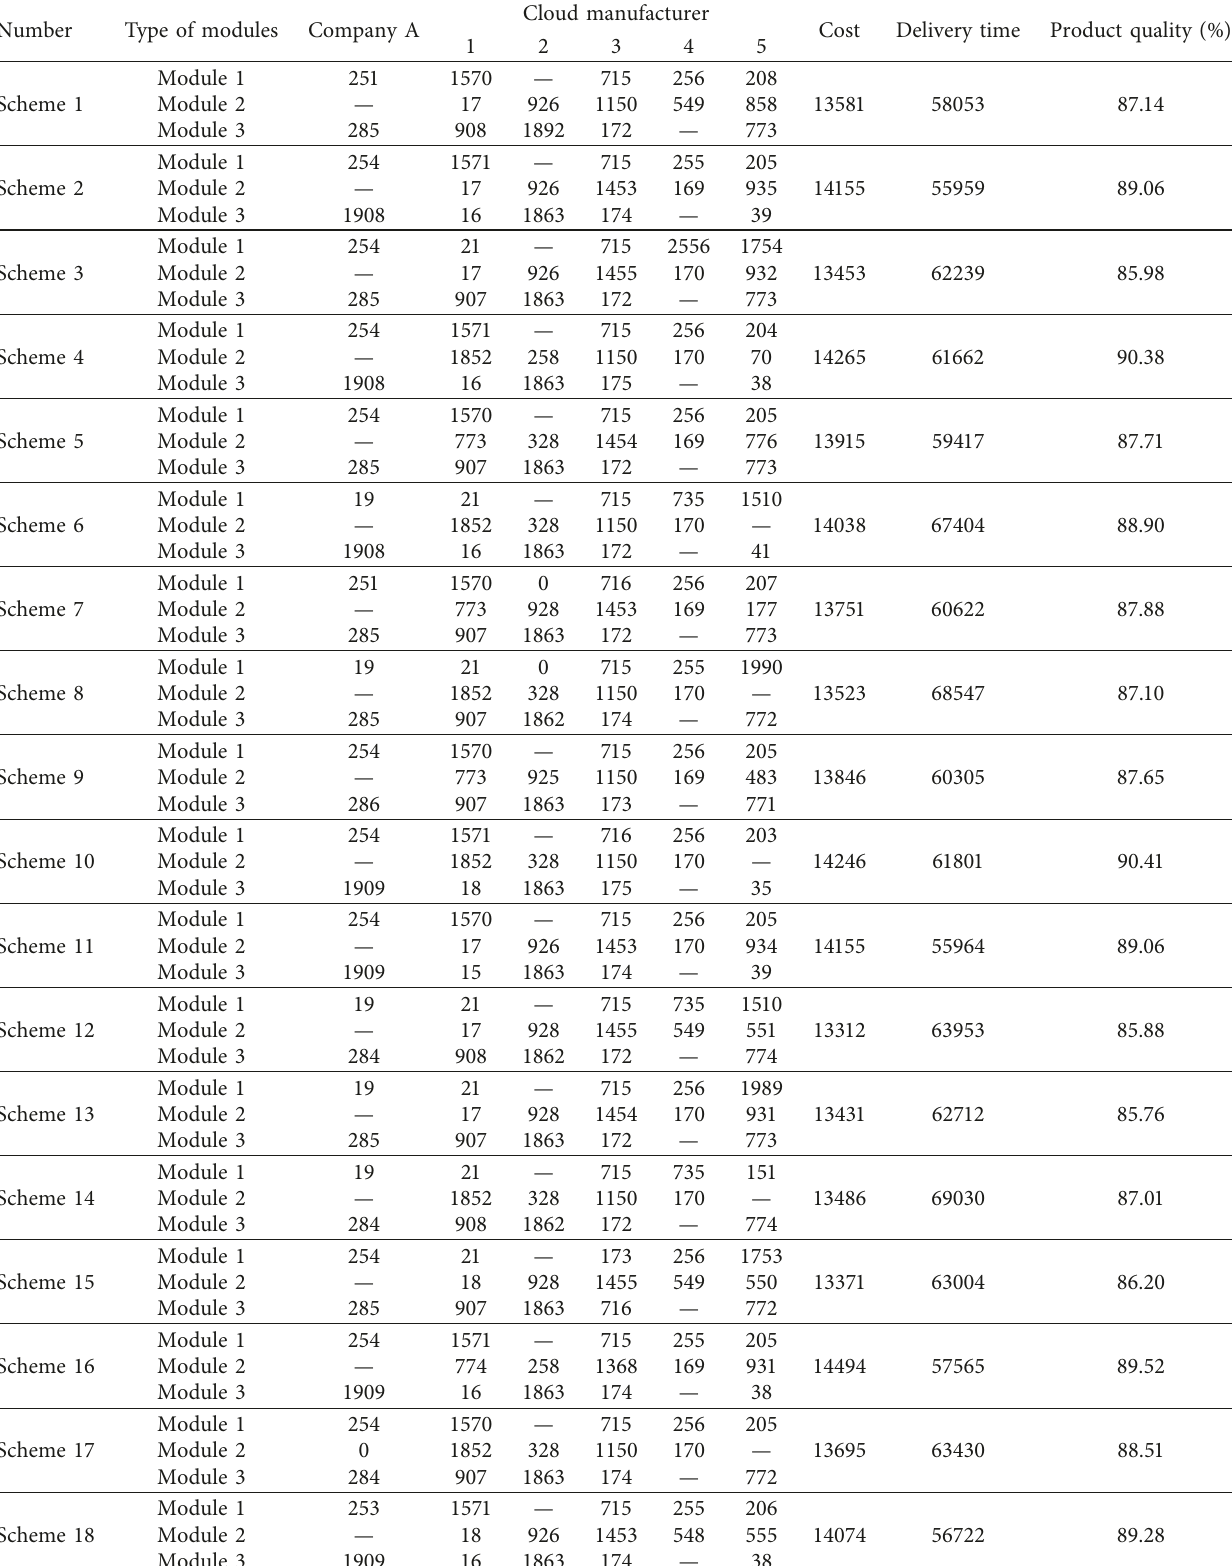
Table 6: Production planning set corresponding to completely nondominating solutions obtained by